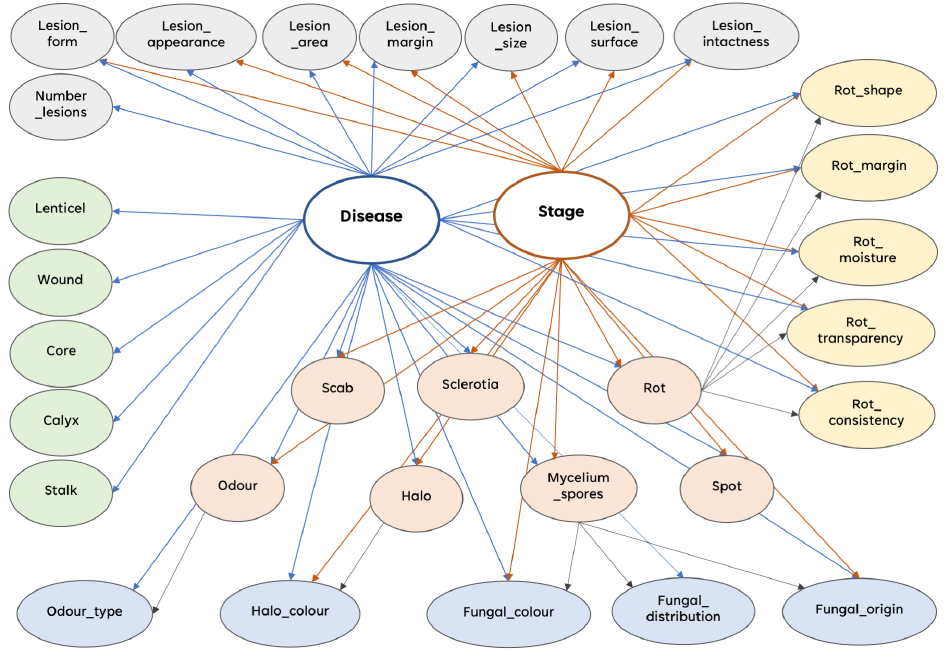
Figure 2. The Bayesian network graphical